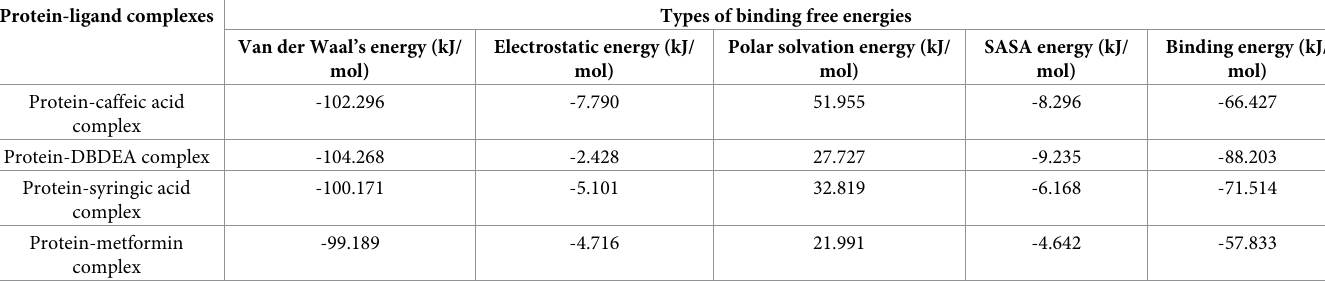
Table 5. Binding free energy values of JME phytocompounds and metformin complexed with human MAPK3 protein. Protein-ligand complexes